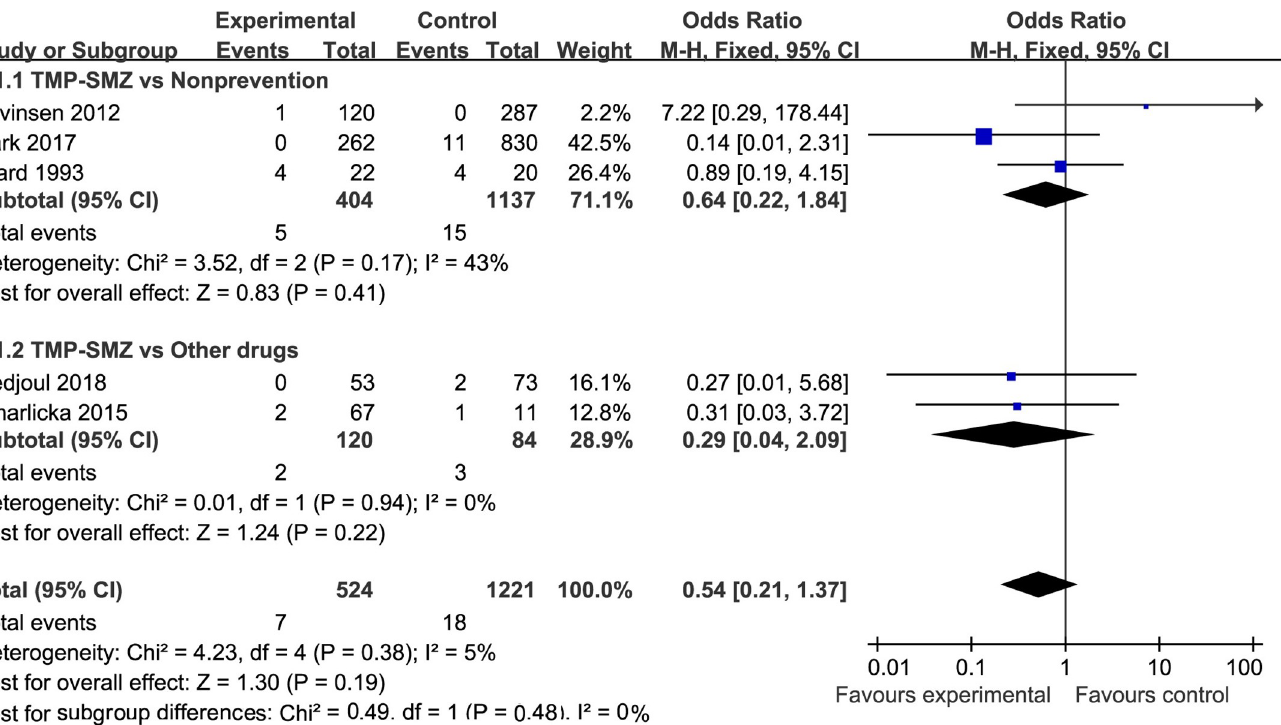
Fig 4. Forest plot of the rate of mortality. The vertical line indicates no difference between the groups. ORs are represented by diamonds, and 95% CIs are depicted by horizontal lines. Squares indicate point estimates, and the size of each square indicates the weight of the given study in the meta-analysis. M-H, Mantel-Haenszel fixed- effects model.